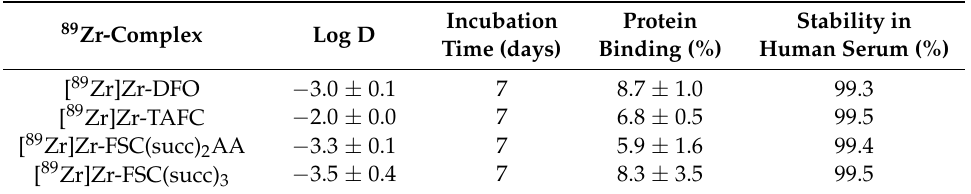
Table 1. LogD, protein binding, and stability in human data for [ 89 Zr]Zr-DFO, [ 89 Zr]Zr-TAFC,